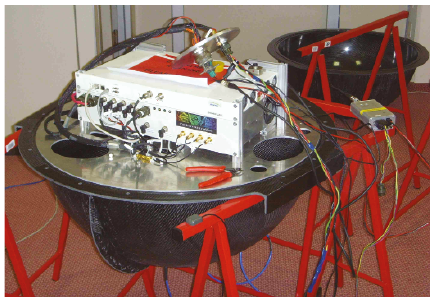
Figure 7: Payload interior